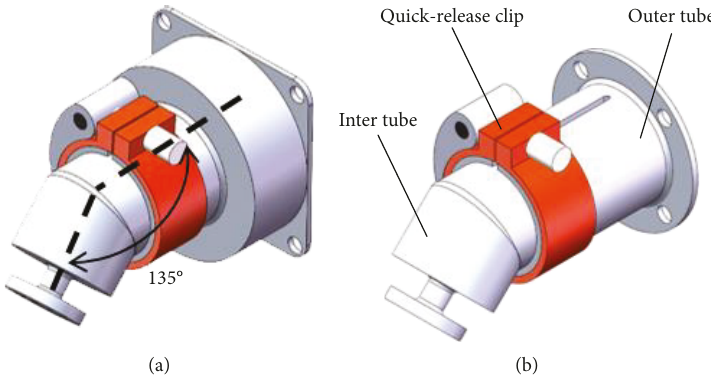
Figure 6: Structure of the transformable mechanism: (a) driving wheel and (b) driven